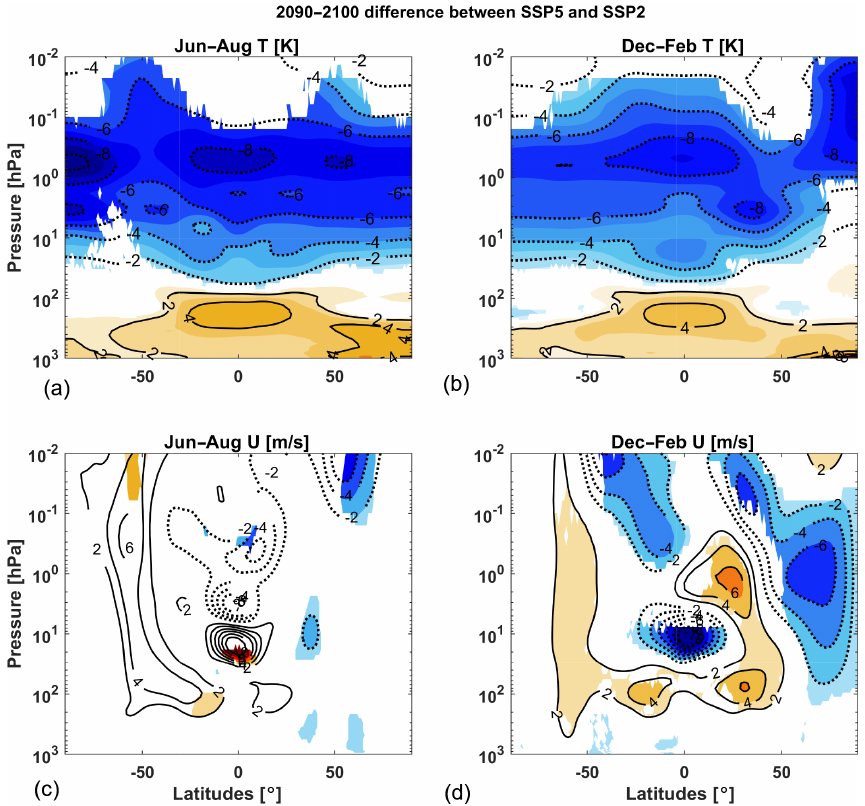
Figure 6. Difference in the zonal mean temperature ( a June–August, b December–February) and zonal mean zonal wind ( c June–August, d December–February) between SSP5 and SSP2 during 2090–2100. Positive contour levels are 2, 4, 6, 8 and 10 (solid lines), and negative contour levels are − 2, − 4, − 6, − 8 and − 10 (dotted lines) as K for temperature and m / s for zonal wind. Colour shading indicates areas significant at the 95% level calculated with a Monte Carlo simulation and a false detection rate.